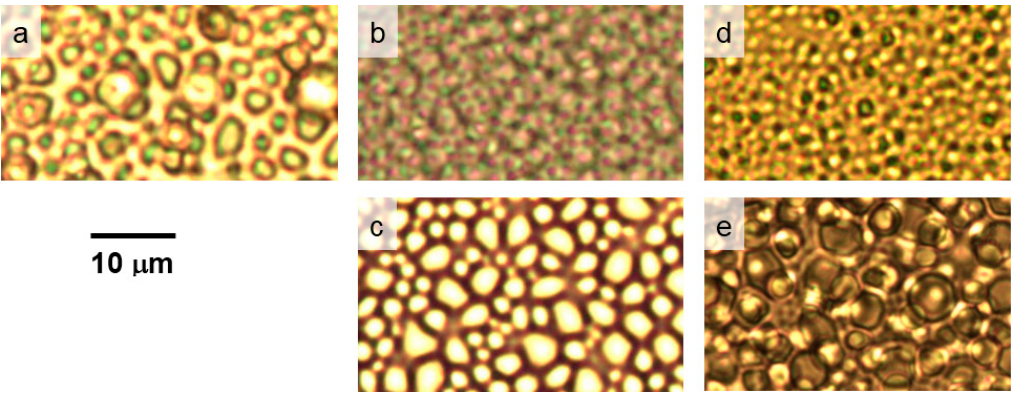
Figure 9. Photomicrographs of the neat PVME solution ( c P = 5 wt % in D 2 O) ( a ) and solutions with additives TBMK ( b ); TBME ( c ); TBOH ( d ); and TBAm ( e ) ( c P = 5 wt %, c ad = 5 wt %) recorded at temperatures above the transitions of the particular systems.